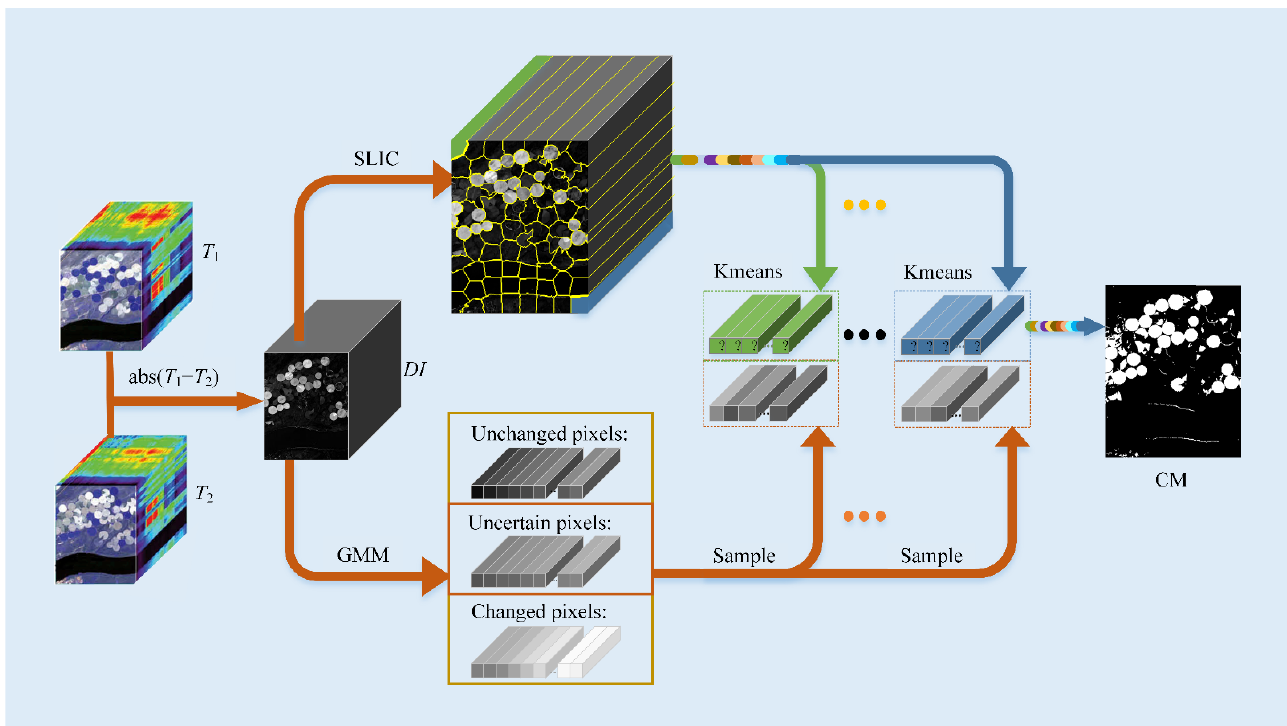
Figure 1. The proposed SSCF for change detection of HSIs.